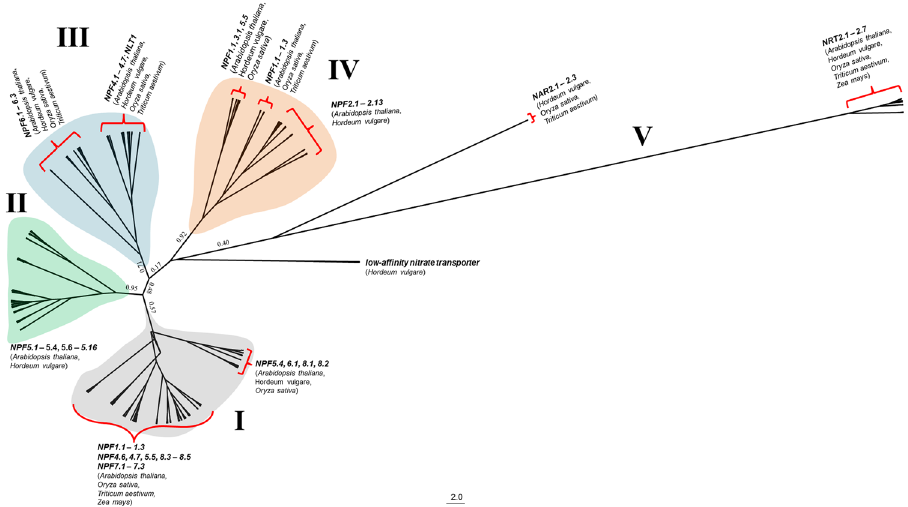
Figure 5. An unrooted Bayesian coalescent tree of wheat nitrate transporter genes constructed from multiple alignment of protein sequences. The clades are divided into five groups, as shown, with Roman numerals I – V. Branches within each clade are annotated with either the names of known genes or with GenBank descriptions, and their plant species, based on blastx results. Posterior probabilities are reported only for the main clades. Because of a large taxa number, most of the branch lengths and taxa names are not shown; this information is provided in Supplementary